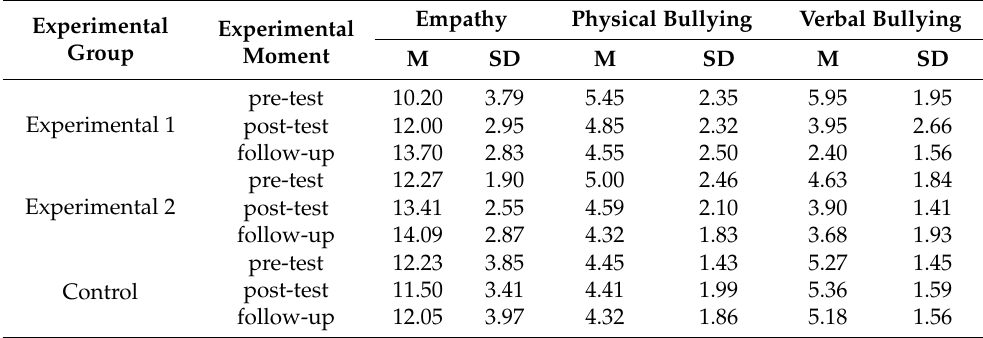
Table 3. Means and standard deviation coefficients for empathy, physical bullying, and verbal bullying for all experimental groups and